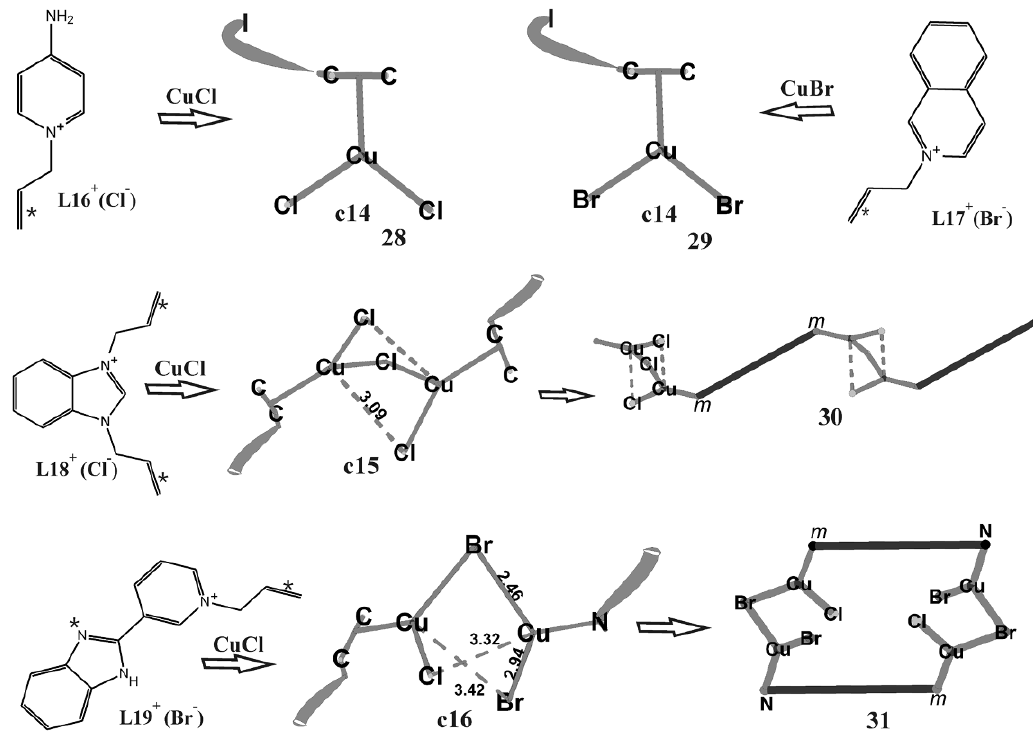
Figure 7. Structural genesis of C14-C16 fragments in 28-31